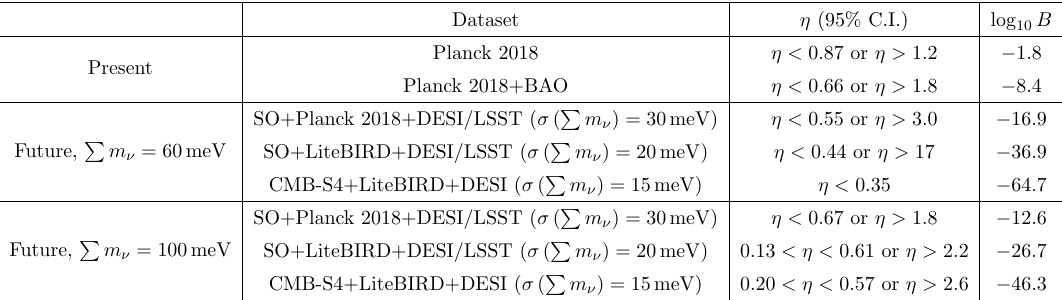
Table 1 . 95% credible intervals for the parameter (cid:17) from current cosmological data, and projections for future experiments, combined with data from oscillation experiments, in the ( (cid:17) > 0 ; (cid:17) 0 > 0 ; (cid:17) (cid:21) (cid:17) 0 ) region of parameters. Note that oscillation data require that (cid:17) (cid:21) 0 : 088 in this region of the parameter space, so this constraint should be always understood. Constraints in the full parameter space can be reconstructed from symmetry arguments in the ( (cid:17) (cid:0) (cid:17) 0 ) plane, see text for details. The constraints in the (cid:12)rst row are computed from a combination of the most up-to-date cosmological data available, namely the full Planck 2018 data release, possibly combined with measurements of the baryon acoustic oscillations from BOSS/SDSS. In the following rows we also report forecast results for di(cid:11)erent combinations of future cosmological surveys, in order of increasing sensitivities: Simons Observatory and CMB-S4 combined with either Planck or LiteBIRD and BAO data from DESI/LSST, see text for details. In case of future surveys, we forecast results assuming that the true value of the summed neutrino masses is either P m (cid:23) = 60 meV or P m (cid:23) = 100 meV, corresponding to the minimal possible masses for normal and inverted ordering. The constraints are computed according to the prescription discussed in the appendix. In the last column we also show the logarithm of the Bayes factor between the quasi-degenerate and non-degenerate scenarios B (cid:17) P deg = (1 (cid:0) P deg ). Negative values in that column indicates a preference for non-degenerate neutrinos. The preference gets exponentially larger as the absolute value of log B increases. 10 we approximate the posterior P ( P m ) from KATRIN data as a semi-Gaussian peaked in (cid:23) 0 and with standard deviation (cid:27) ( P m ) = 0 : 36 eV. In this case, odds of 2 : 1 are obtained (cid:23) in favour of nondegenerate masses (log B = (cid:0) 0 : 10